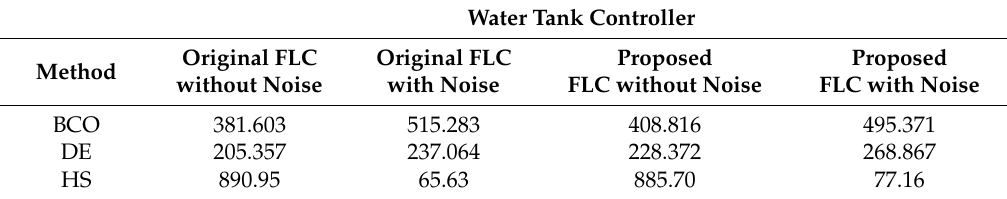
Table 12. Comparison of the time obtained from the water tank controller for the original and proposed algorithms.